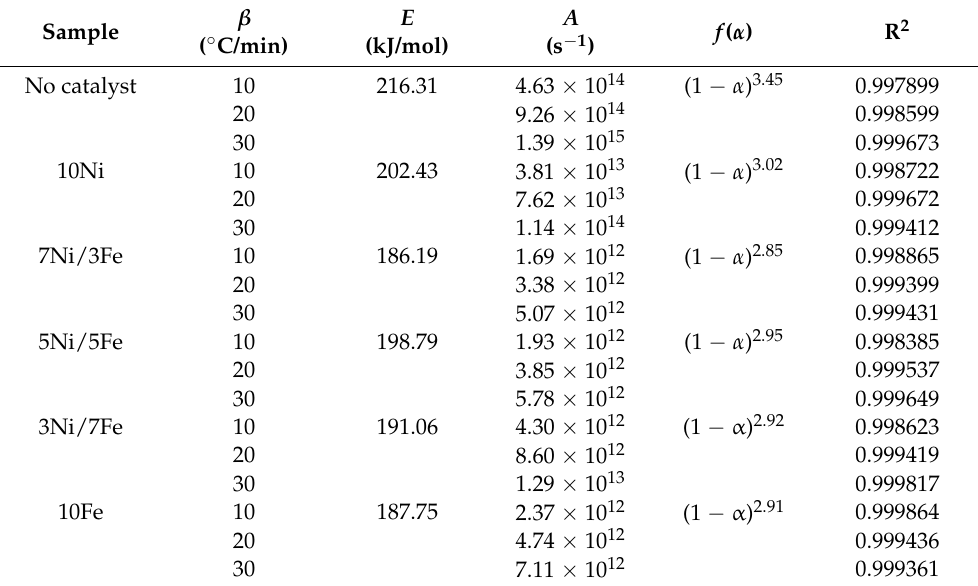
Table 5. Kinetic triplets of WT catalytic pyrolysis at 10, 20, and 30 ◦ C/min by master-plots method.